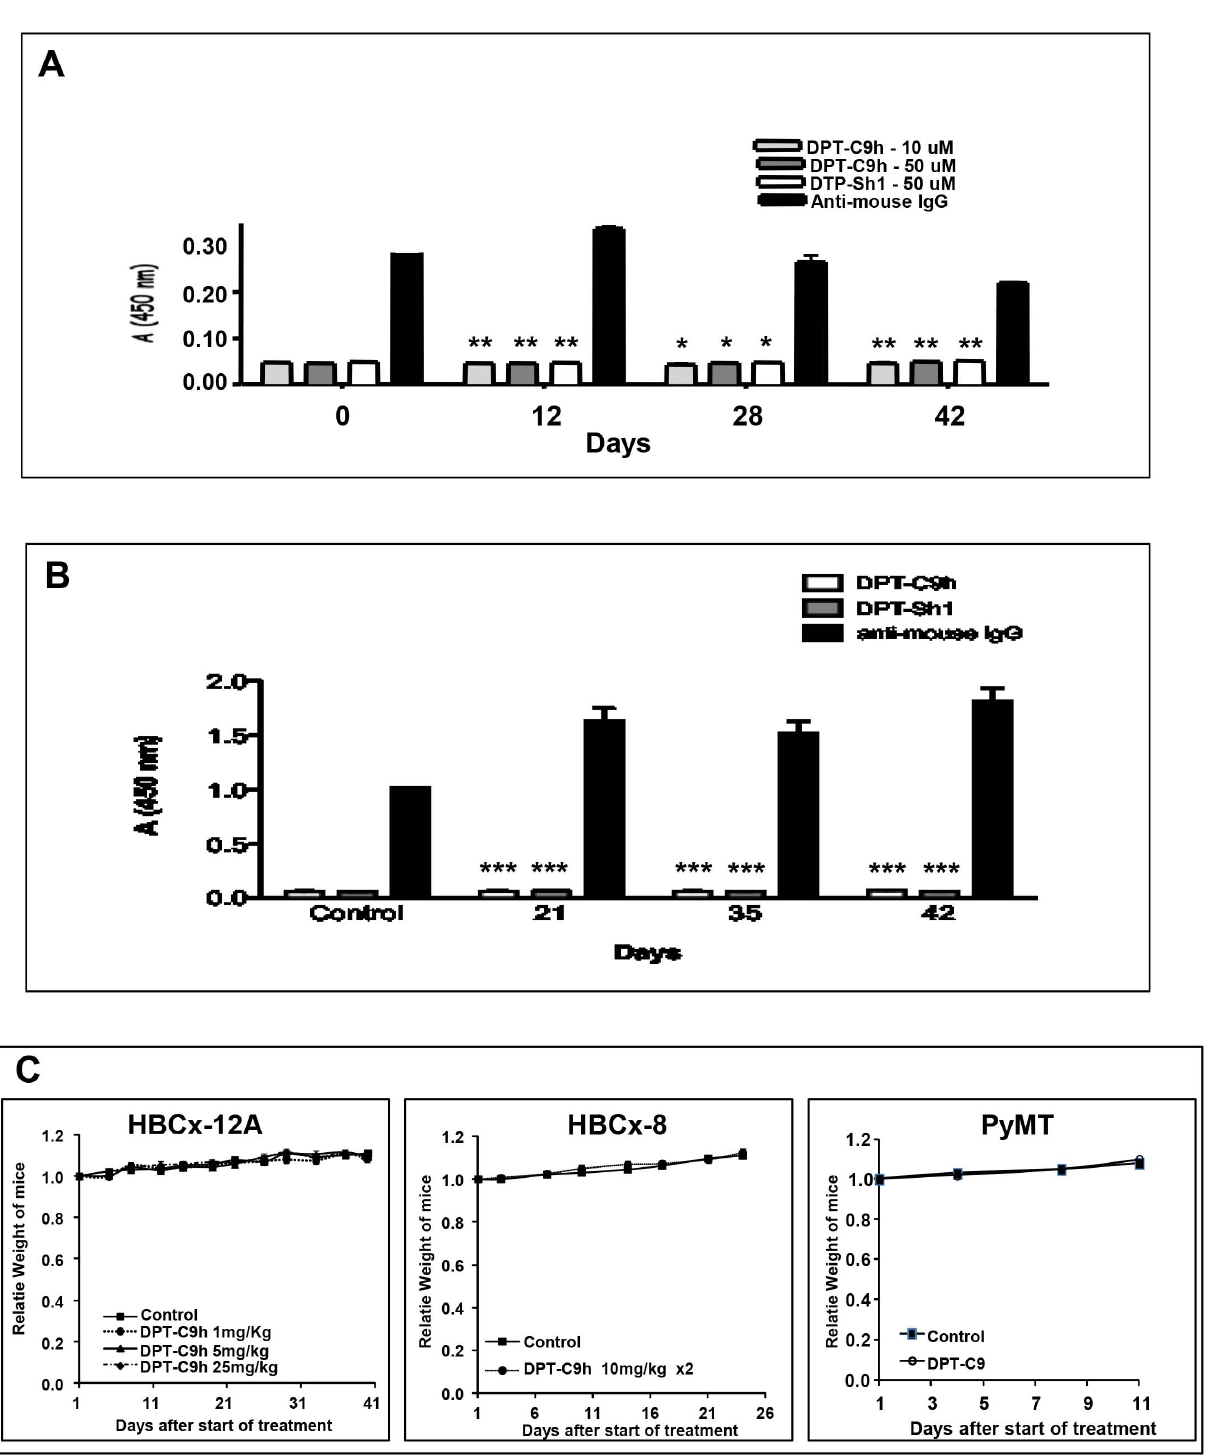
Figure 5. Invivo antibody responses and toxicity induced by DPT-C9h. A ) Serum antibodies taken from nude mice treated for different periods of time were detected by ELISA at two different concentrations of DPT-C9h peptide (10 and 50 m M). B ) Serum antibodies from wild type mice treated for different periods for time were tested by ELISA against DPT-C9h and DPT-Sh1 (50 m M). C ) DPT-C9h was intraperitoneally administered in mice bearing tumors HBCx-12A at 1, 5, or 25 mg/kg once daily for 5 weeks; the median weight of mice for each experimental group is represented at different times. A total of 10 mice were included per group. Similarly, DPT-C9h was intraperitoneally administered in mice bearing tumours HBCx-8 at 10 mg/kg twice daily for 4 weeks. DPT-C9 was IP administrated at mice model PyMT model at dose of 5 mg/kg. The median weight of mice for each experimental group is represented at different times. Ten mice were included per group.